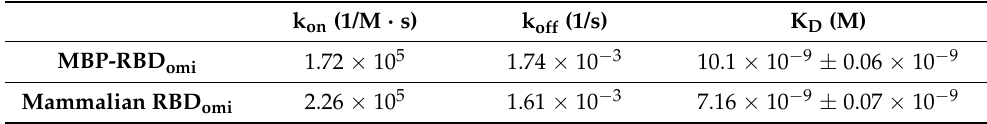
Table 1. Kinetic constants for the binding affinities of the Omicron RBDs to the human ACE2 receptor determined by